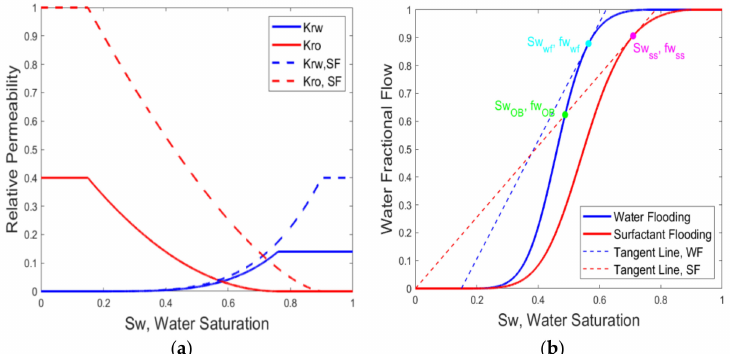
Figure 7. ( a ) Water–oil relative permeability curves in the absence and presence of surfactant; and ( b ) Fractional flow curves in the absence and presence of surfactant (no adsorption, no partition) and construction of the respective shock front for water flooding and surfactant